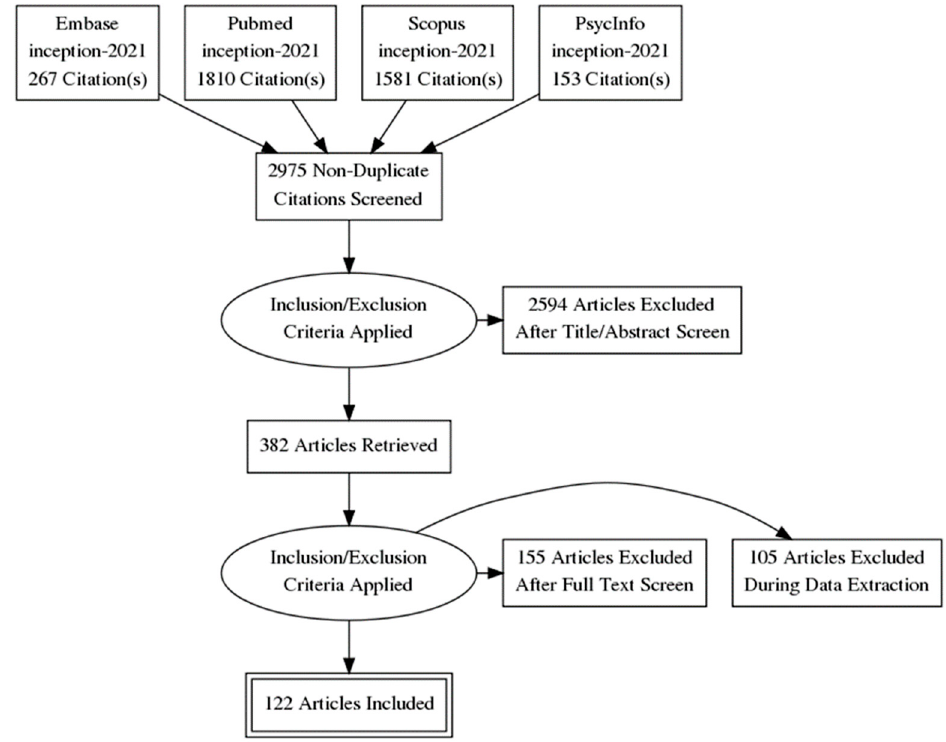
Figure 1. Preferred Reporting Items for Systematic Reviews and Meta-Analysis (PRISMA) flow di-